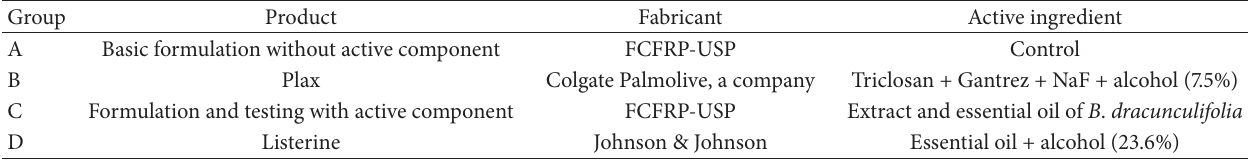
Table 1: Summary of the products tested for efficacy in controlling